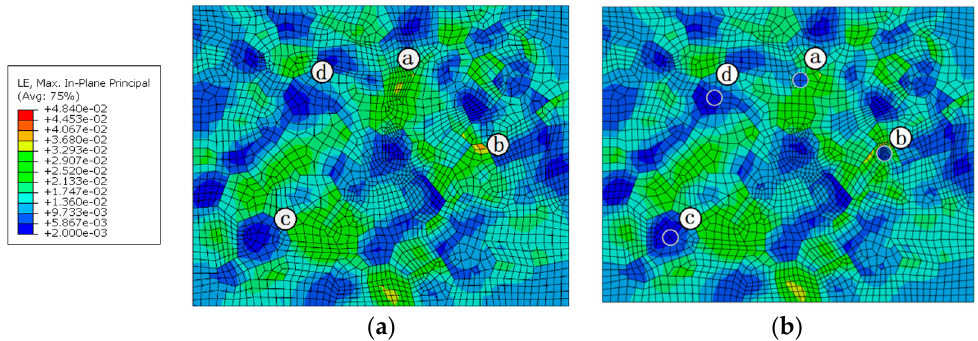
Figure 15. Maximum principal strain distribution of WNZ in the joint models that ( a ) only contain crystal characteristics, and ( b ) include crystal characteristics and hardening particles. Table 4. Maximum von Mises stress of RVE in each zone (MPa).